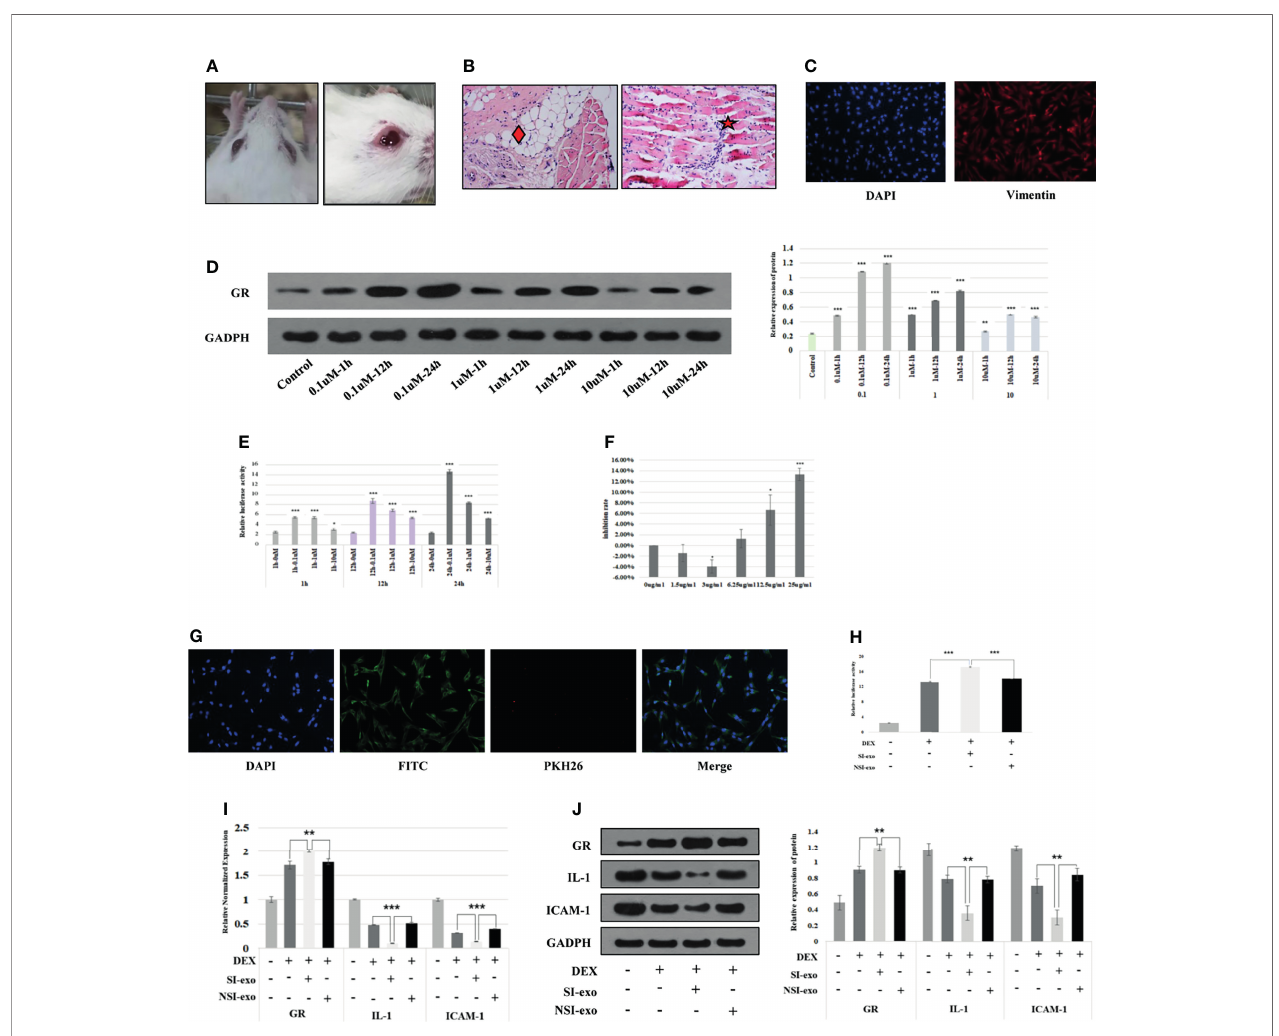
FIGURE 2 | SI-exo improves the glucocorticoid sensitivity of OFs. (A) Eye pictures of GO mice. (B) HE staining of retrobulbar tissue of GO mice (SP*200); “ ♦ ” : fat in fi ltration; “ ★ ” : in fl ammatory cell in fi ltration. (C) Results of primary OFs immuno fl uorescence identi fi cation; DAPI: labeling the OF nucleus with blue fl uorescence; Vimentin: labeling vimentin with red fl uorescence. (D) The Western blot result of the GR protein expression level when OFs in DEX at 0.1, 1, and 10 m M for 1, 12, and 24 h, respectively. Compared with the control group: * p < 0.05; ** p < 0.01; *** p < 0.001. (E) The GRE luciferase reporter plasmid activity result when OFs in DEX at 0.1, 1, and 10 m M for 1, 12, and 24 h. Compared with the 0- m M group: * p < 0.05; ** p < 0.01; *** p < 0.001. (F) CCK8 results of OFs in exosomes at 1, 1.5, 3, 6.25, 12.5, and 25 m g/ml for 24 h. Compared with the 0- m g/ml group: * p < 0.05; *** p < 0.001. (G) Immuno fl uorescence results of coculture of plasma exosomes and OFs. DAPI: labeling the OF nucleus with blue fl uorescence; PKH26: labeling plasma exosomes with red fl uorescence; FITC: labeling cytoskeleton with green fl uorescence. (H) Plasmid activity of GRE luciferase reporter gene results in each group. DEX: 0.1 m m DEX-treated OFs for 24 h; SI-exo/NSI-exo: 25 m g/ml SI-exo/ NSI-exo-treated OFs for 24 h; * p < 0.05; ** p < 0.01; *** p < 0.001. (I) Statistical chart of PCR detection of GR, IL-1, and ICAM-1 mRNA levels in each group. Grouping and statistical methods are the same as (I) . (J) Western blot detection of GR, IL-1, and ICAM-1 protein levels and statistical chart in each group. Grouping and statistical methods are the same as (I)